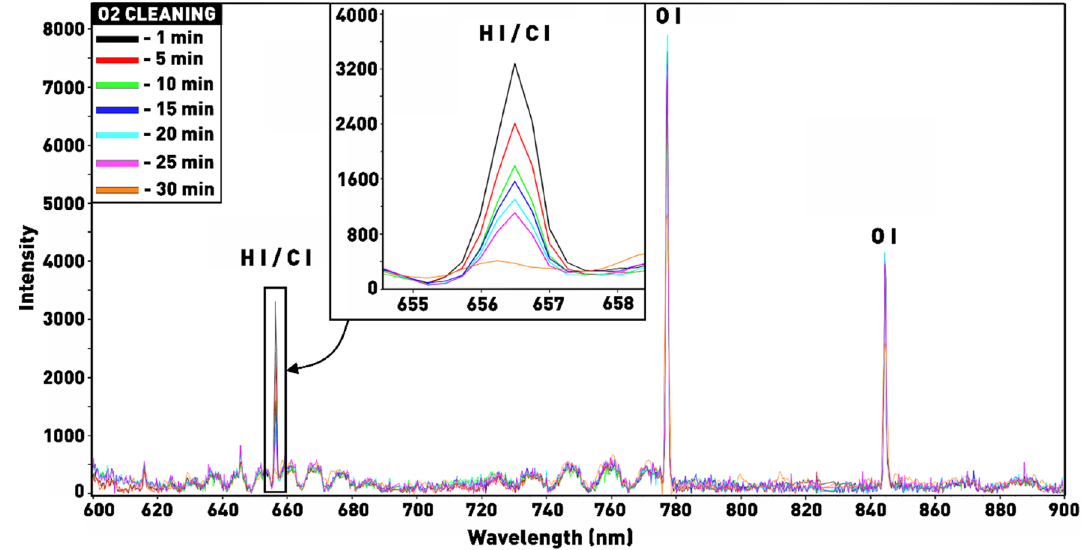
Figure 15. Emission spectra recorded during polystyrene etching in oxygen